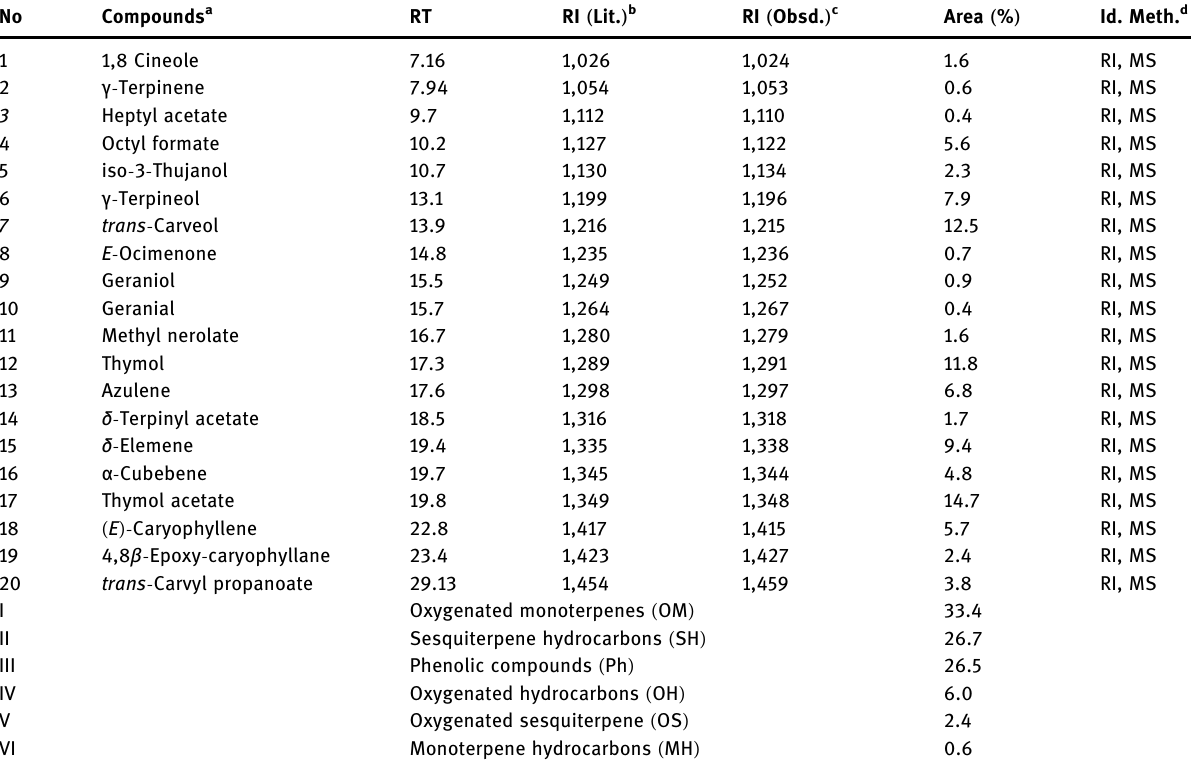
Table 1: Chemical composition of the essential oil of the aerial parts of Equisetum arvense No Compounds a